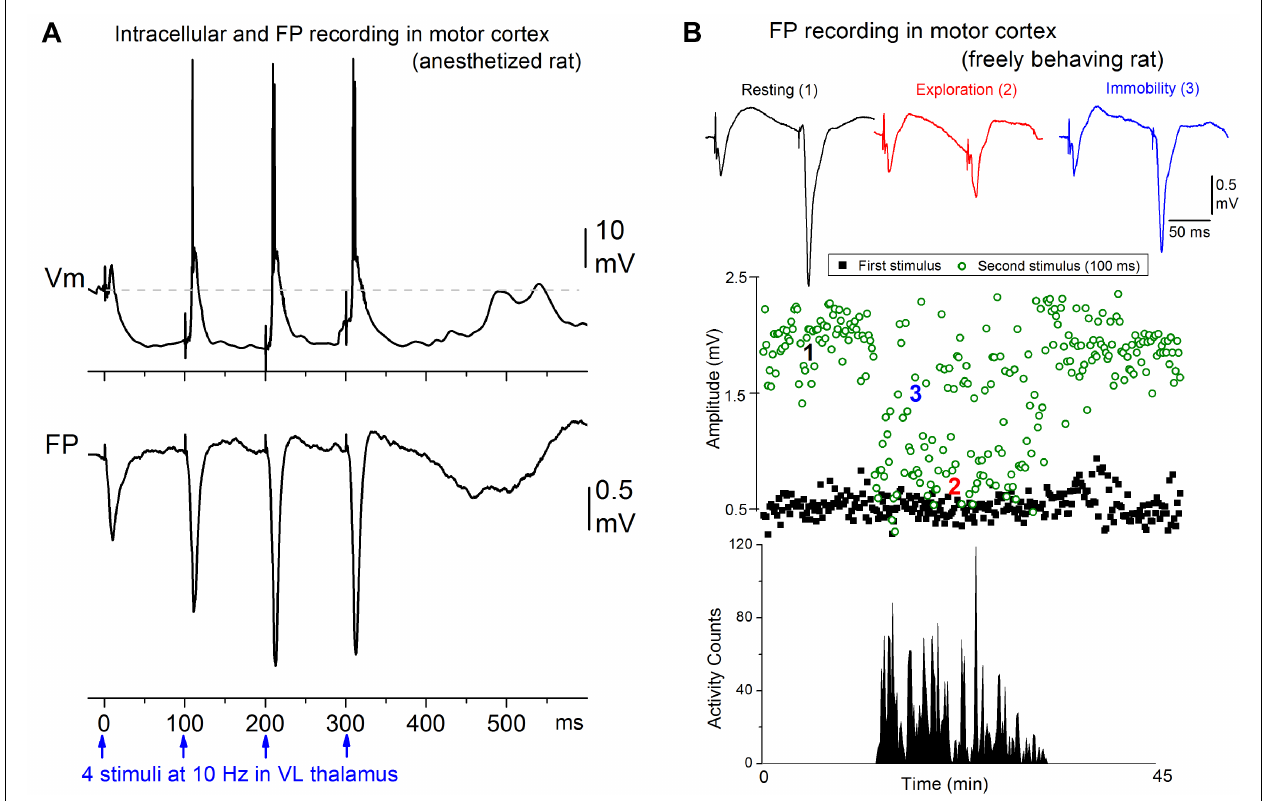
(Castro-Alamancos and Connors, 1996c).The animal was allowed to freely explore the cage and locomotor activity was monitored with photobeam detectors.The amplitude of the responses to the first and second stimulus delivered at 10 Hz is plotted.The augmenting response is induced during periods of resting and awake immobility but is inactivated during periods of active